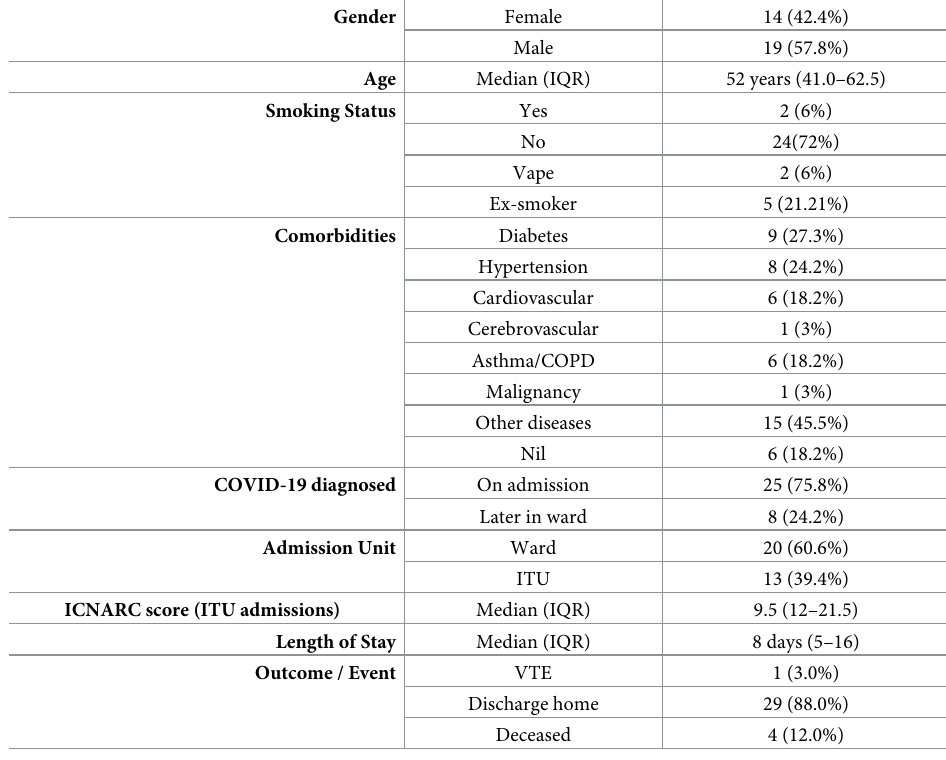
Table 1. Demographic data of enrolled patients admitted to hospital with COVID-19 (n =